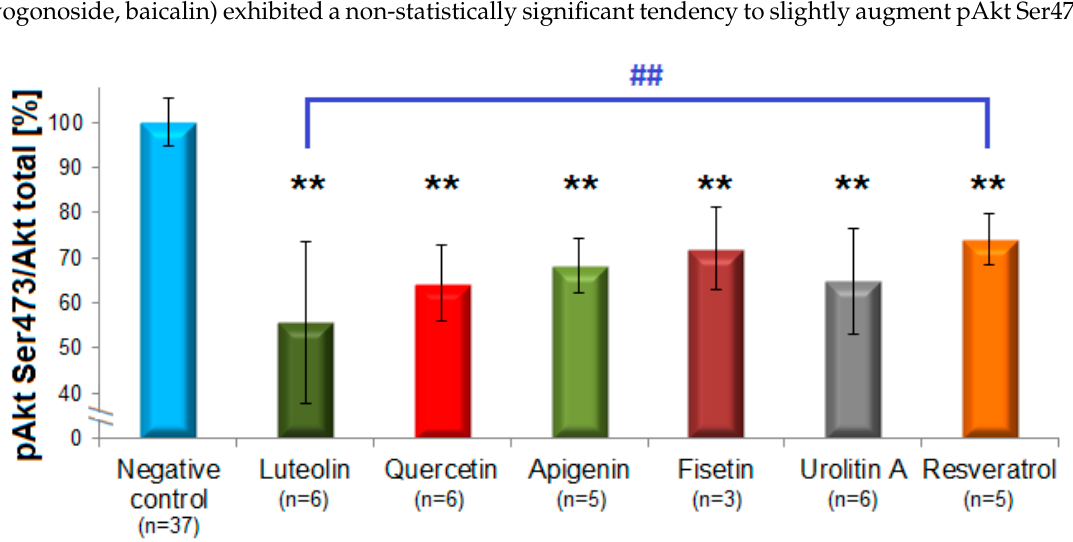
Figure 3. Polyphenols from different subclasses showing more pronounced pAkt-inhibition. The columns represent means of the residual phosphorylation (in %) with standard deviations. Statistically significant inhibitions were observed for the flavones luteolin and apigenin, the flavonols fisetin and quercetin, the dibenzo- α -pyrone urolithin A and the stilbenoid resveratrol (n = 3–6), ** p < 0.01. The difference between the effects of luteolin and resveratrol was statistically significant as well, ## p < 0.01 (one-way ANOVA with Tukey HSD test).